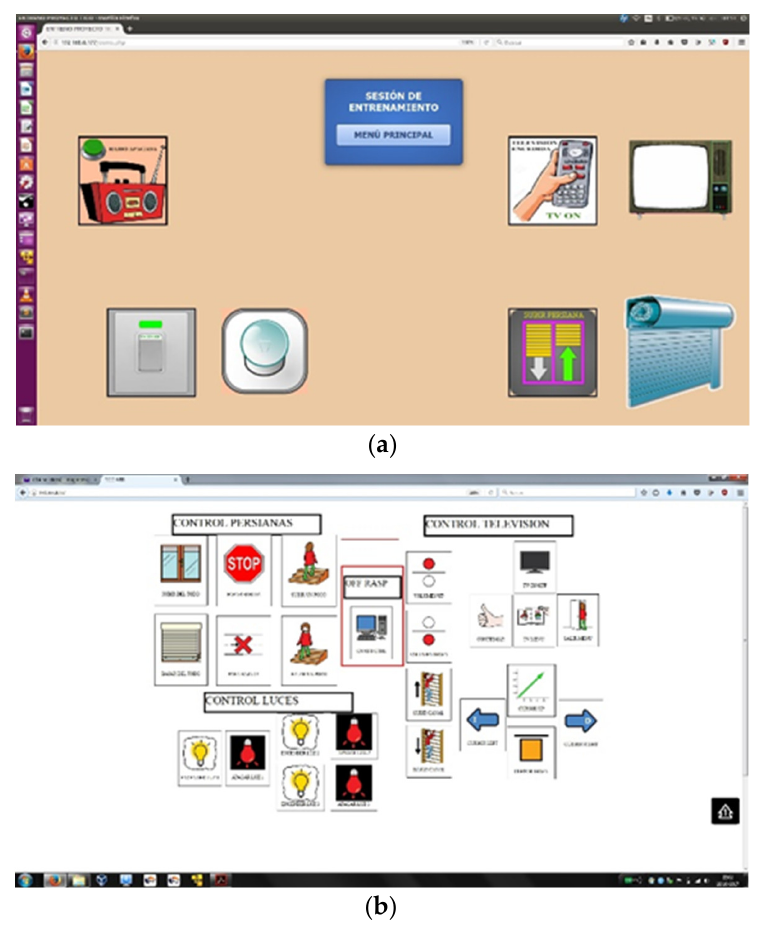
Figure 13. TICO–home-control: interface accepts pictograms, drawings, or pictures to adapt to several cognitive accessibility conditions: ( a ) interface for training at the school library; ( b ) interface for a room.